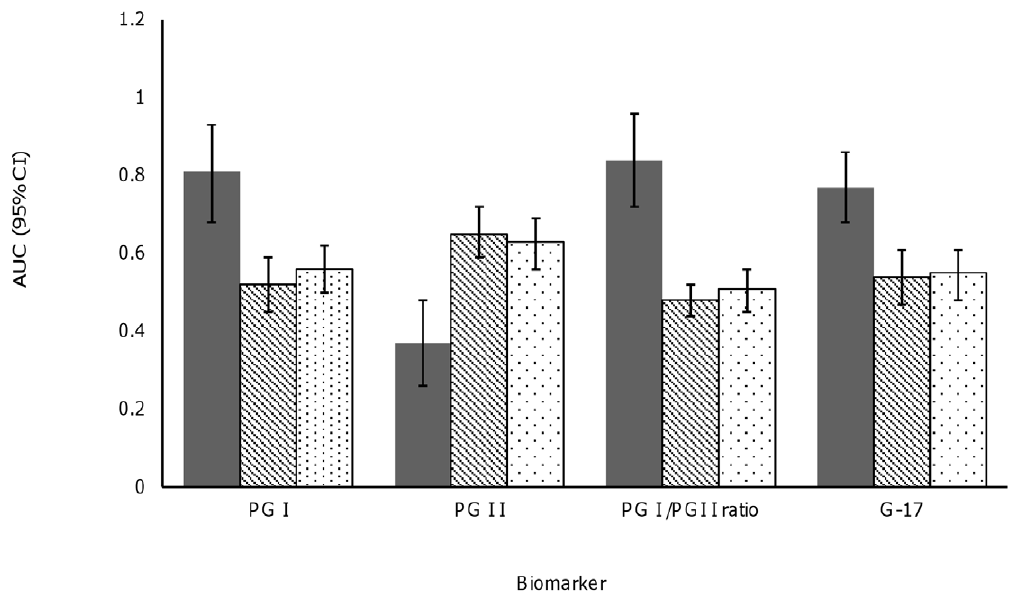
Figure 2. AUCs for discrimination of fundic atrophy (dark bar), and nonatrophic pangastritis (dotted bar represents the study population after exclusion of fundic atrophy from reference group, diagonal lined bar represents whole study population). AUC: Area under curve, PGI: pepsinogen I, PGII. pepsinogen II, PGI/PGII ratio: pepsinogen I/pepsinogen II ratio, G-17: gastrin-17.